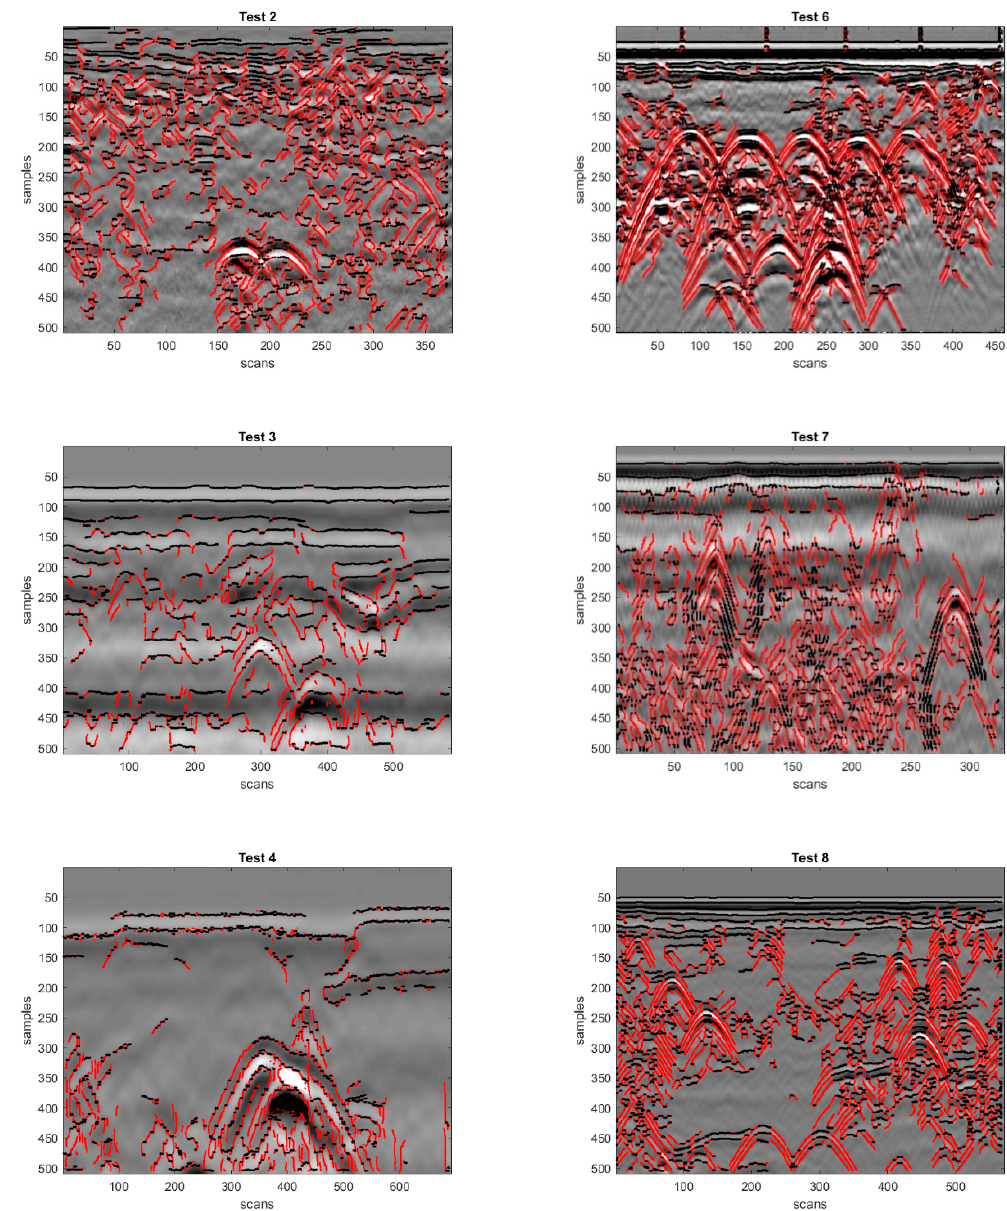
Figure 8. Edge pixel removal results obtained with experimental test data, when using search zone (d).